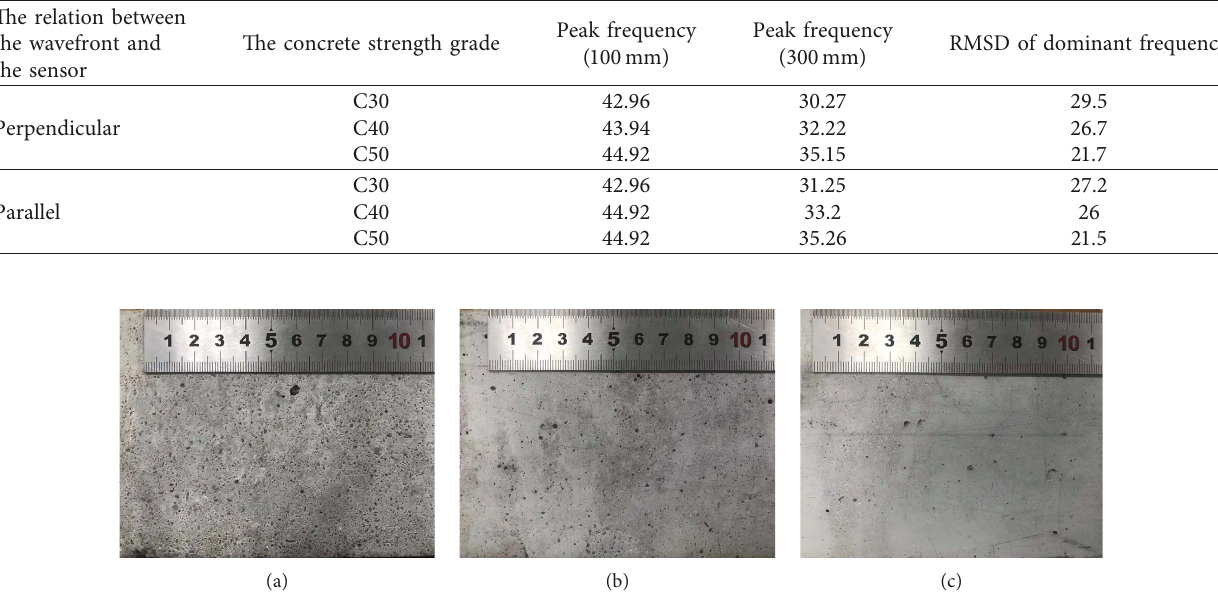
Figure 15: Frequency-domain spectra of acoustic emission signals in concrete with strength grade. (a) C30, (b) C40, and (c) C50. Table 3: The variation of peak frequency and RMSD index in two cases.